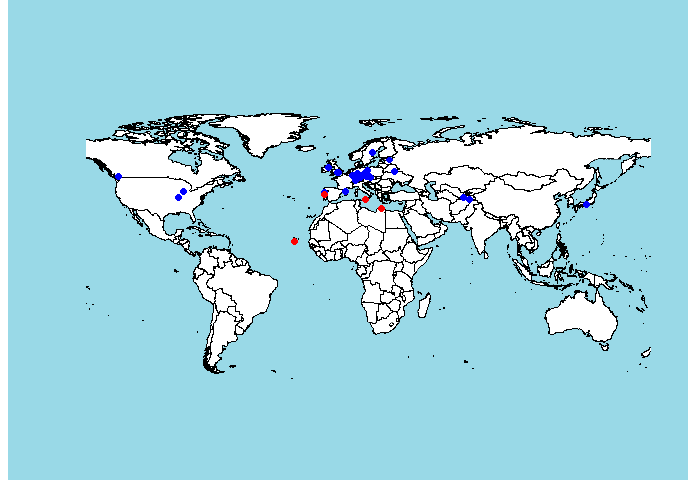
Figure 6. Relationships between the mean temperature at the site of ecotype origin and basal level of abscisic acid (ABA) content in the shoot ( A ) and the ratio between ABA and total cytokinin content in the shoot (ABA / CK ratio) in the shoot ( B ) in A. thaliana ecotypes. Commonly use ecotypes are marked in colour (Red = Col-0, Blue = Ws-0, Orange = Ler-1). See Table 1 for the full list of ecotypes.